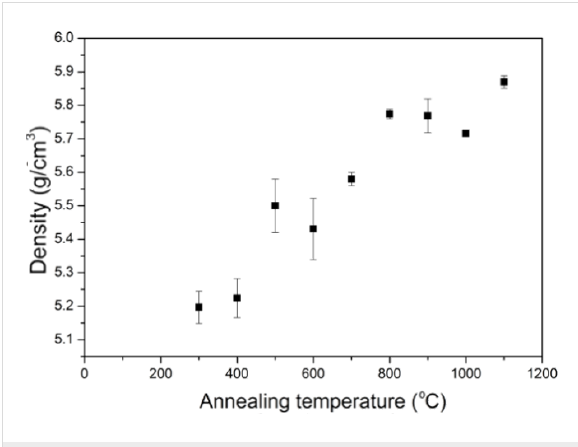
Figure 7: Density as a function of annealing temperature of nano-ZrO 2 powder.